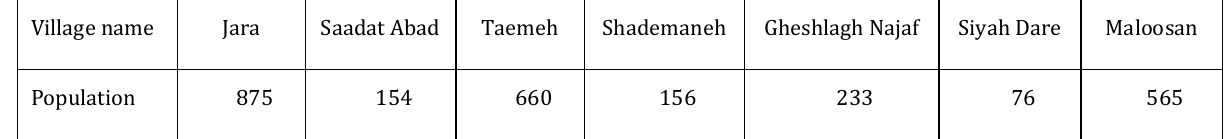
Table 1. Population of villages in the study